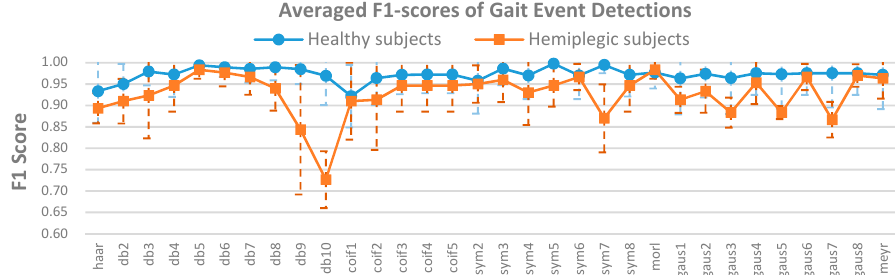
Figure 7. Averaged F1-scores of HS and TO gait event detection over all the healthy subjects (blue line) and over all the hemiplegic subjects (red line) across different mother wavelets. The vertical dashed lines indicate the standard deviation.